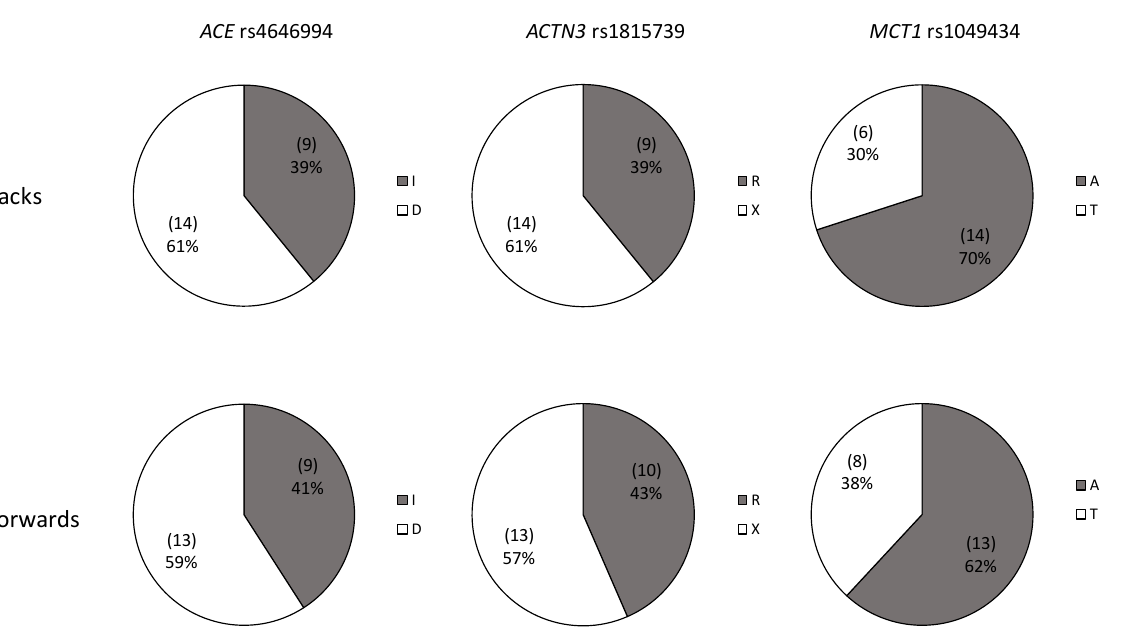
Figure 5. Allele distribution in elite rugby union players for playing position.